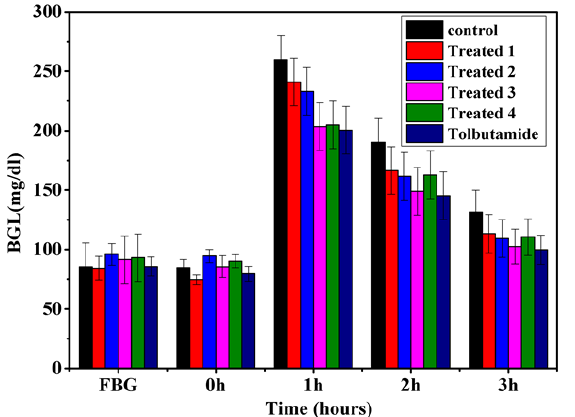
Figure 6. Effect of graded doses of t. dioica leaves aqueous extract on BGL during GTT in subdiabetic rats. Control: Distilled water, Treated 1: 500 mg/kg bw, Treated 2: 750 mg/kg bw, Treated 3: